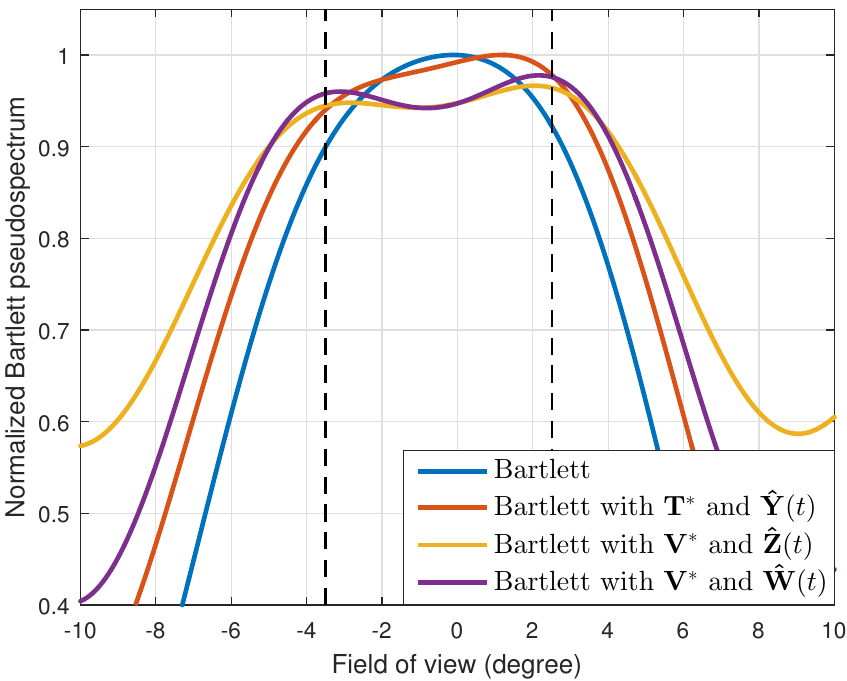
Figure 2. Normalized Bartlett pseudospectrums for two adjacent targets located at [ − 3.5 ◦ , 2.5 ◦ ]